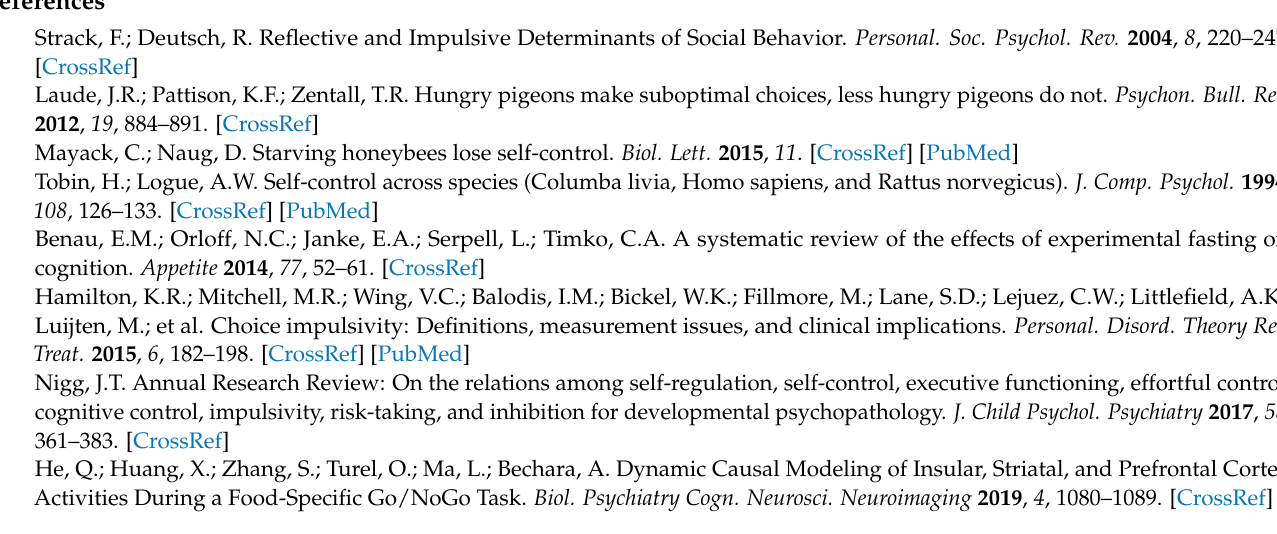
Table S1: Demographic information of participants, Table S2: Differences in subjective reports and blood hormones across homeostatic state, Table S3. Differences blood hormones at the start and end of each experimental session, Table S4. Linear Mixed Effects Modelling for Total Reaction